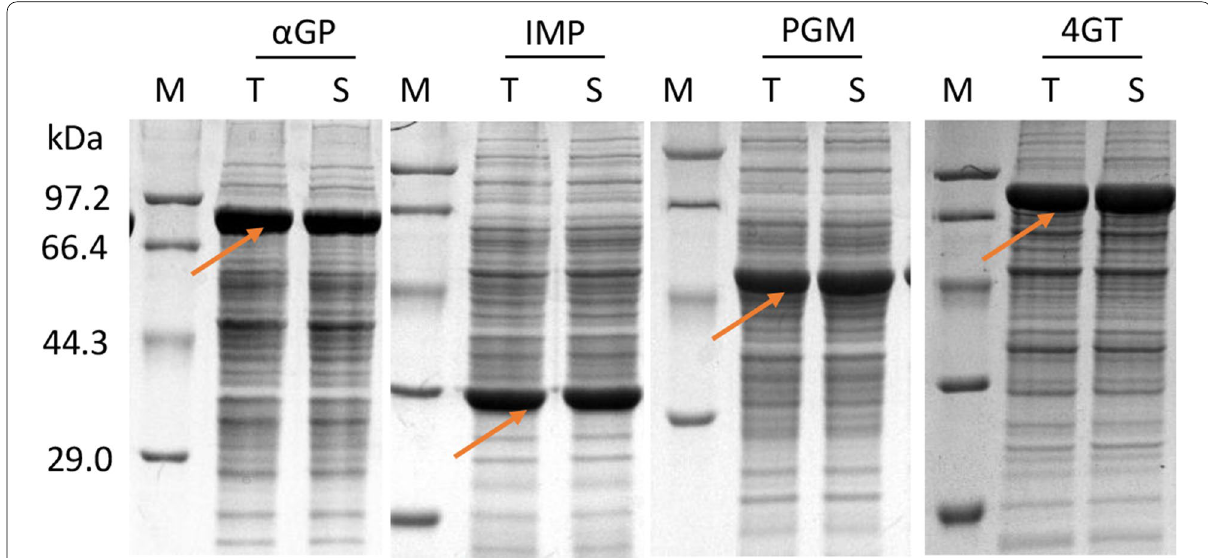
Fig. 5 SDS‑PAGE analysis of targeted protein expression in B . subtilis SCK22. Lanes: M the standard protein markers, T the total cell lysate, S the supernatant of the total cell lysate, αGP α‑glucan phosphorylase, IMP inositol monophosphatase, PGM phosphoglucomutase, 4GT